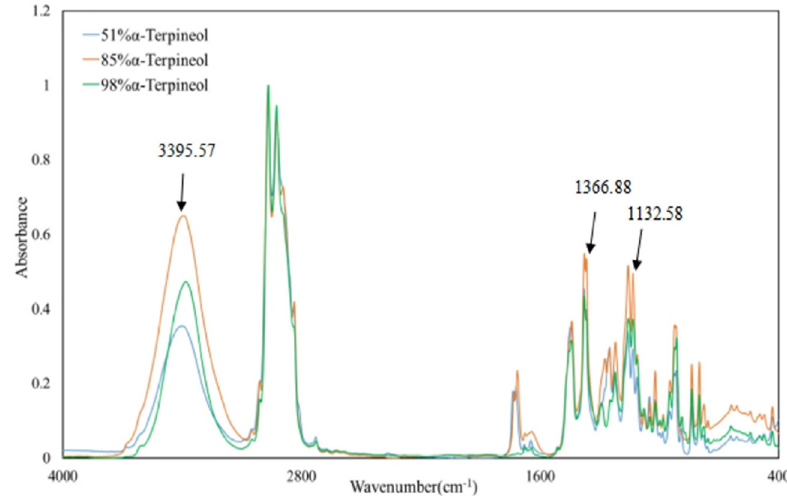
Figure 14. Infrared spectrum of terpineol sample.